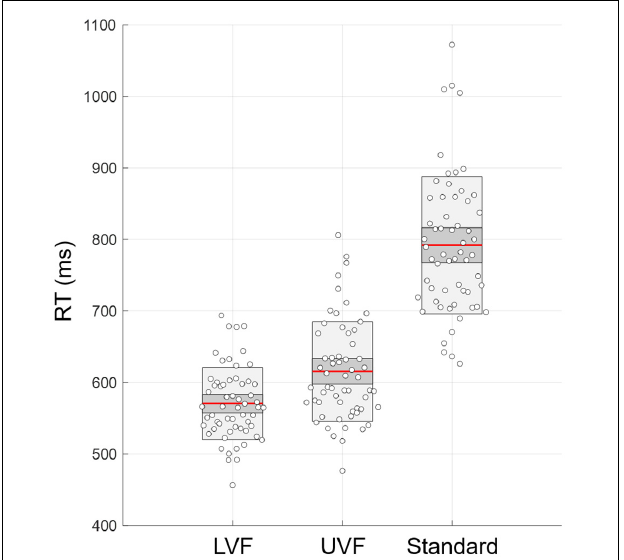
FIGURE 4 | Response times (RT) calculated as the mean of both test and retest RTs for the conditions LVF, UVF, and Standard. Red line, mean of the samples; dark gray, standard deviation; light gray, 95% confidence